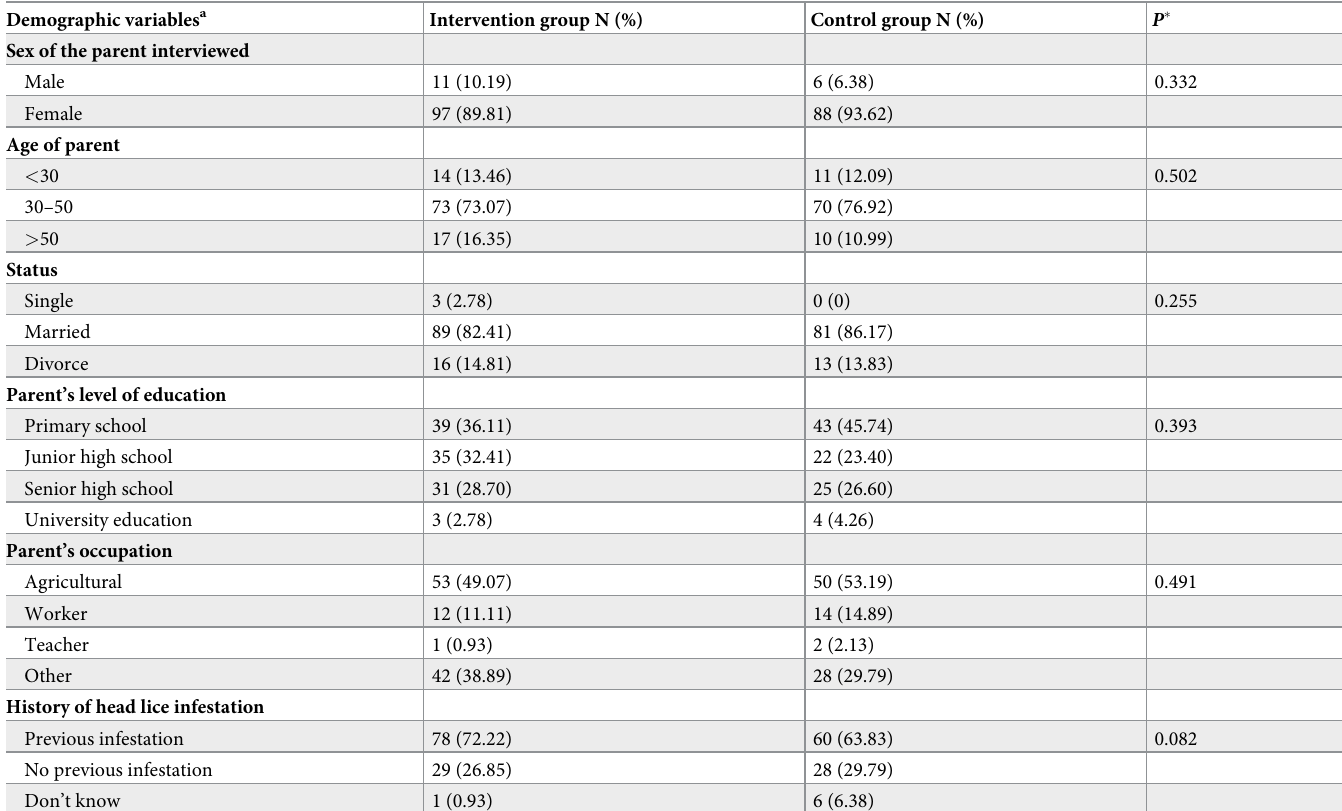
Table 1. Students’ demographic information in intervention and control groups at